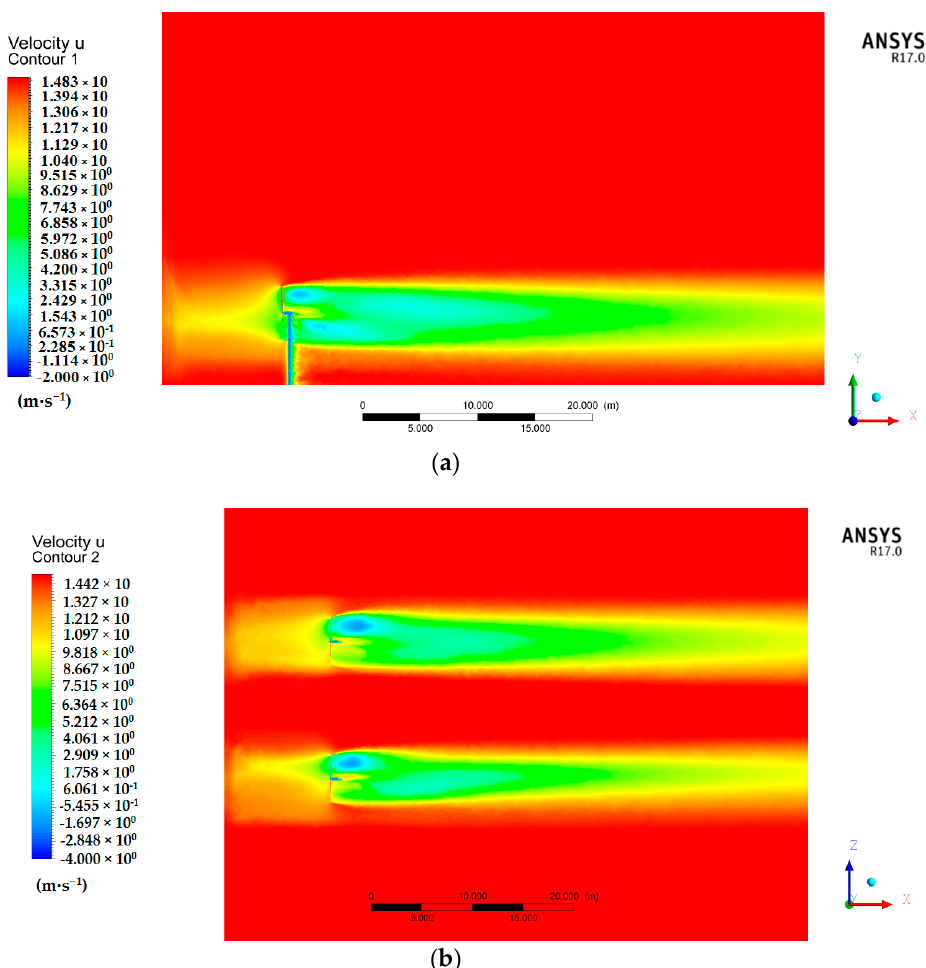
Figure 4. Time-averaged axial velocity contours for the two-turbine case in a hypothetical second row of wind turbines. ( a ) Lateral view of the wake; and ( b ) top view of the wake.